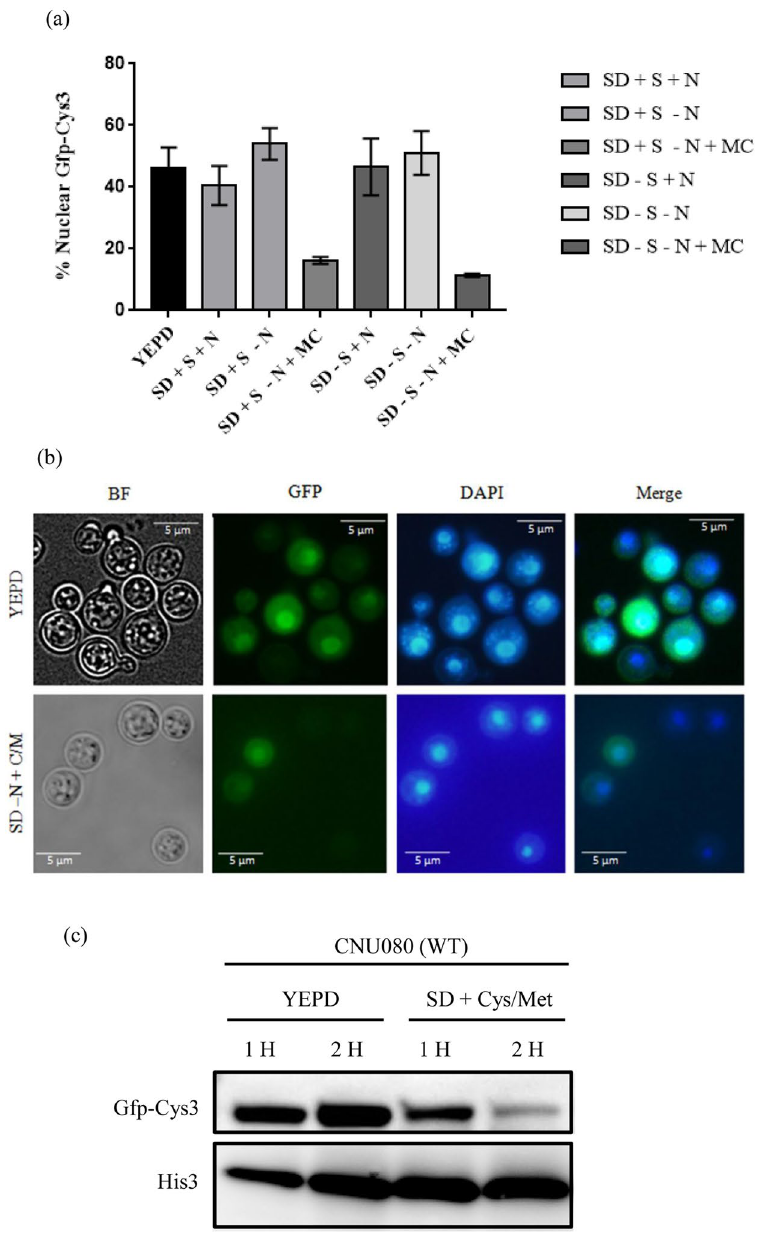
Figure 5. GFP-Cys3 cellular localization and expression pattern in western blotting. ( a ) Percentage of GFP and DAPI localization accessed by fluorescence microscopy in CNU080 submitted to various nutritional conditions (n > 100 cell/treatment, asterisks represent the significant differences ( * p < 0.01 and *** p < 0.001). ( b ) Fluorescence microscopy images showing localization of GFP and DAPI in YEPD (top) and SD-N + Cys/ Met (Bottom). Merge is the overlay of DAPI and GFP images and localization is represented by the yellowish color; ( c ) western blotting of proteins extracted from strain CNU080 cultivated for 1 and 2 h in YEPD and SD-N + Cys/Met. Mouse Anti-GFP primary antibody was used at 1:2000 dilution and secondary anti-mouse horseradish peroxidase-linked antibody was applied at 1:2000 dilution. Loading control was done by detecting histone H3 protein with rabbit anti-His3 antibody (1:2000) as primary and anti-rabbit secondary antibody horseradish peroxidase linked (1:2000). The panel is a crop of a bigger image. The original images are shown in Supplementary